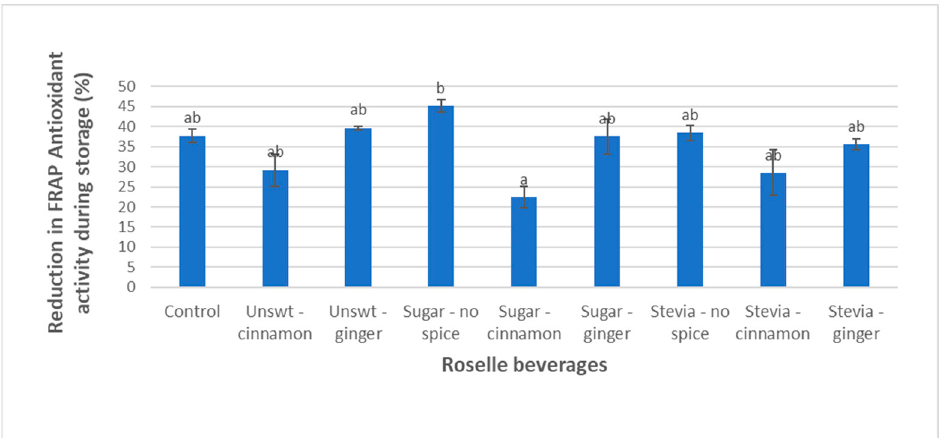
Figure 3. Percentage loss in FRAP antioxidant activity in the Roselle beverages between days 0 and 30 of the accelerated storage at 40 °C. Each bar/point represents mean values + SD. Symbols a and b denote the level of differences between